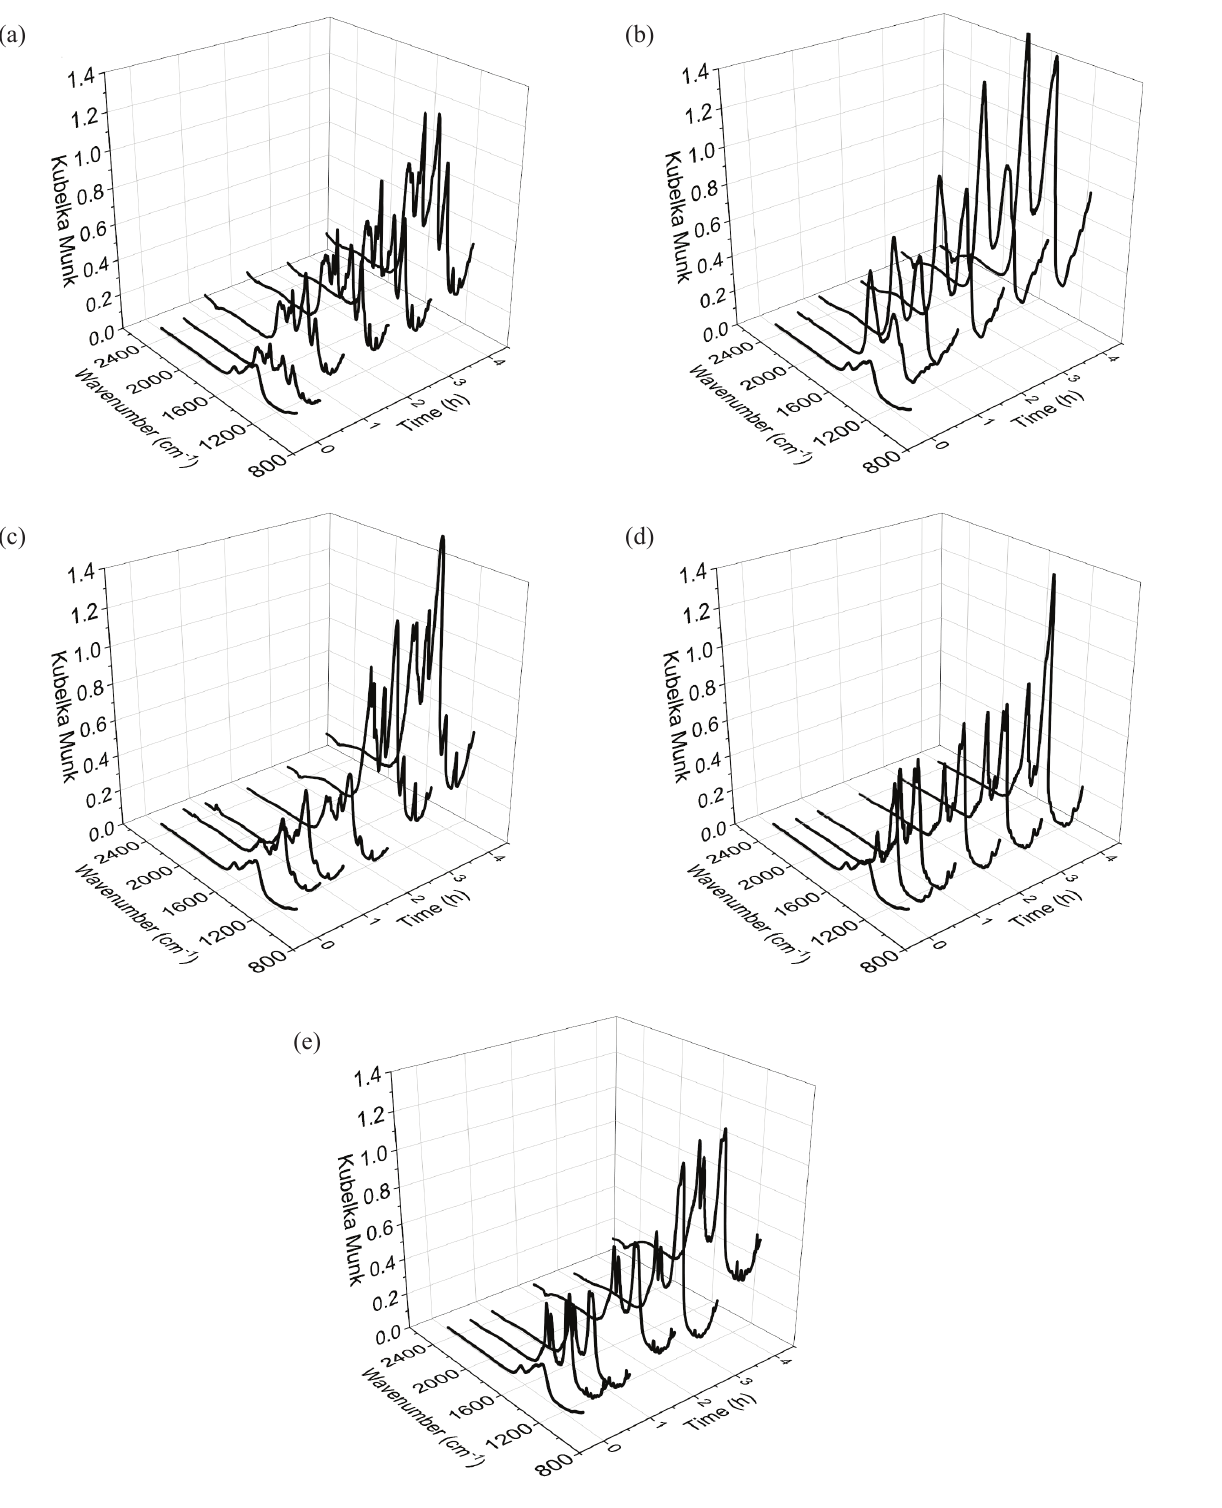
Fig. 5 – Infrared spectra of Mg-Al 2:1 material modified with different API’s – paracetamol (a), ascorbic acid (b), salicylic acid (c), ibuprofen (d), and nicotinic acid